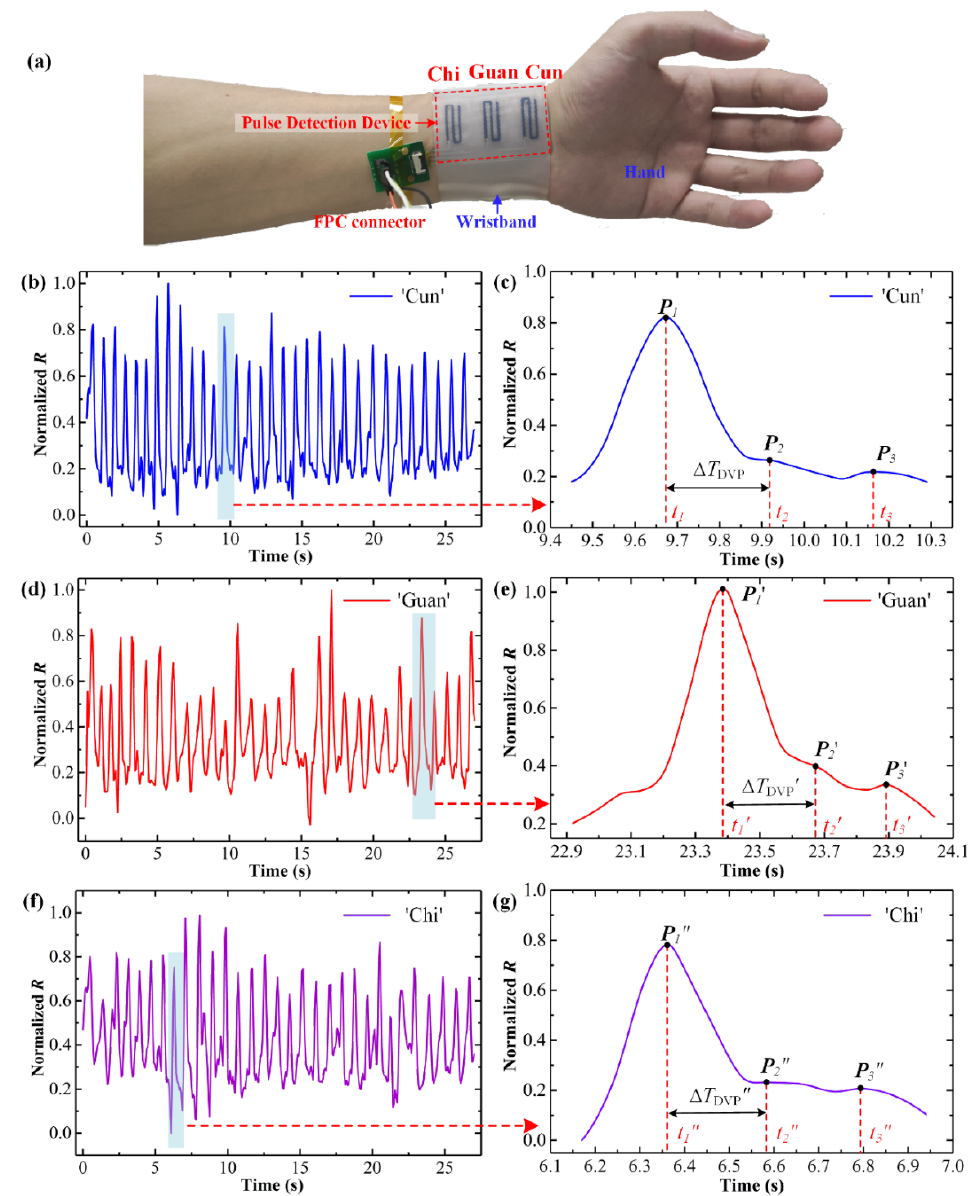
Figure 5. Radial pulse monitoring results: ( a ) pulse detection device worn on the wrist; ( b – g ) pulse signals and their enlarge views of ‘Cun’, ‘Guan’, and ’Chi’ pulse